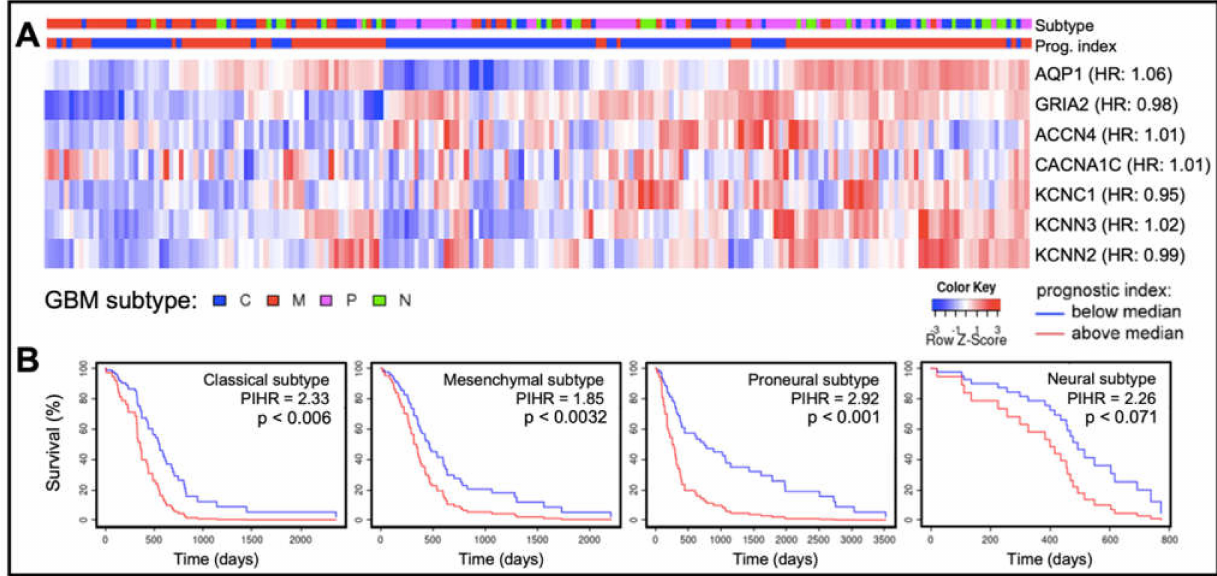
Figure 4. Patterns of expression of ion channels and aquaporin-1 based on transcript levels in human glioblastoma biopsy samples. ( A ) Transcript levels for aquaporin-1 (AQP1), an AMPA glutamate receptor GluR2 (GRIA2), and selected ion channels (acid sensing ion channel-4, ACCN4; Ca V α 1C, CACNA1C; K V 3.1, KCNC1; K Ca 2.3, KCNN3; and K Ca 2.2, KCNN2), compiled from the GBM Bio Discovery Portal database (https://gbm-biodp.nci.nih.gov accessed on 26 September 2021), are presented as heat maps for low (blue) and high (red) transcript levels quantified as FPKM (Fragments Per Kilobase of transcript per Million mapped reads, referenced to the ‘Color Key’), and shown as Z-scores for each patient relative to the average transcript level across the sample population. Samples also are identified by glioblastoma subtype (top bar; referenced to the key ‘GBM subtype’). Gene names are annotated with hazard ratios (HR) from Cox analyses (right side of heat map rows). ( B ) Kaplan–Meier survival curves for each glioblastoma subtype for the cluster of genes summarized in ( A ). In classical, mesenchymal and proneural subtypes, multivariate analysis revealed a significant correlation between patient survival time and the prognostic index hazard ratios (PIHR) of collective AQP1, ion channel and AMPA-type glutamate receptor transcript levels ( p <